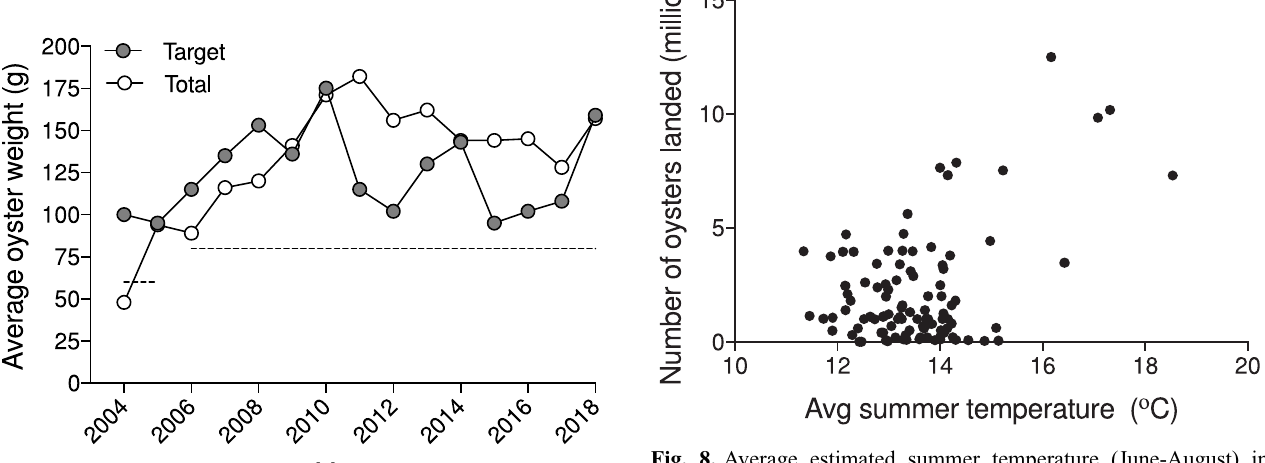
Fig. 8. Average estimated summer temperature (June-August) in Nissum Broad 1900 to 2016 as a function of number of fl at oysters ( Ostrea edulis ) landed fi ve years